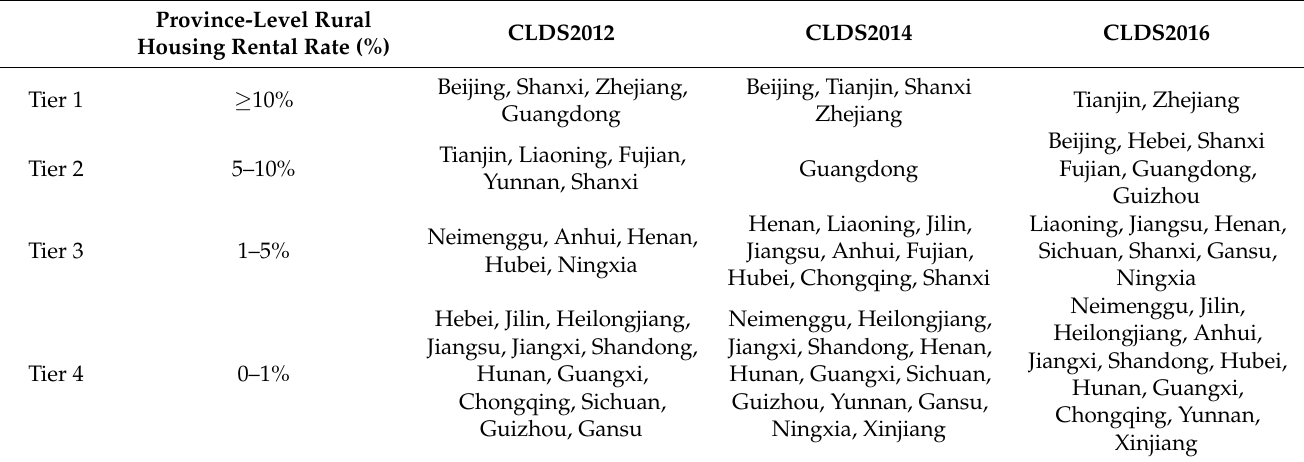
Table 2. Basic situation of China’s rural housing rental rates in each